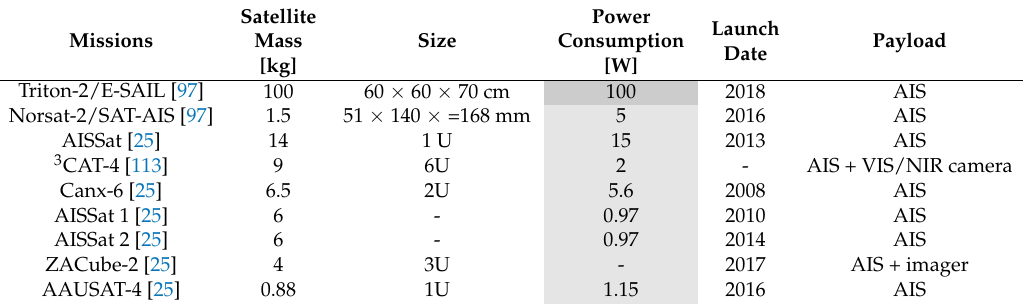
Table A7. Survey of Automatic Identification System (AIS)